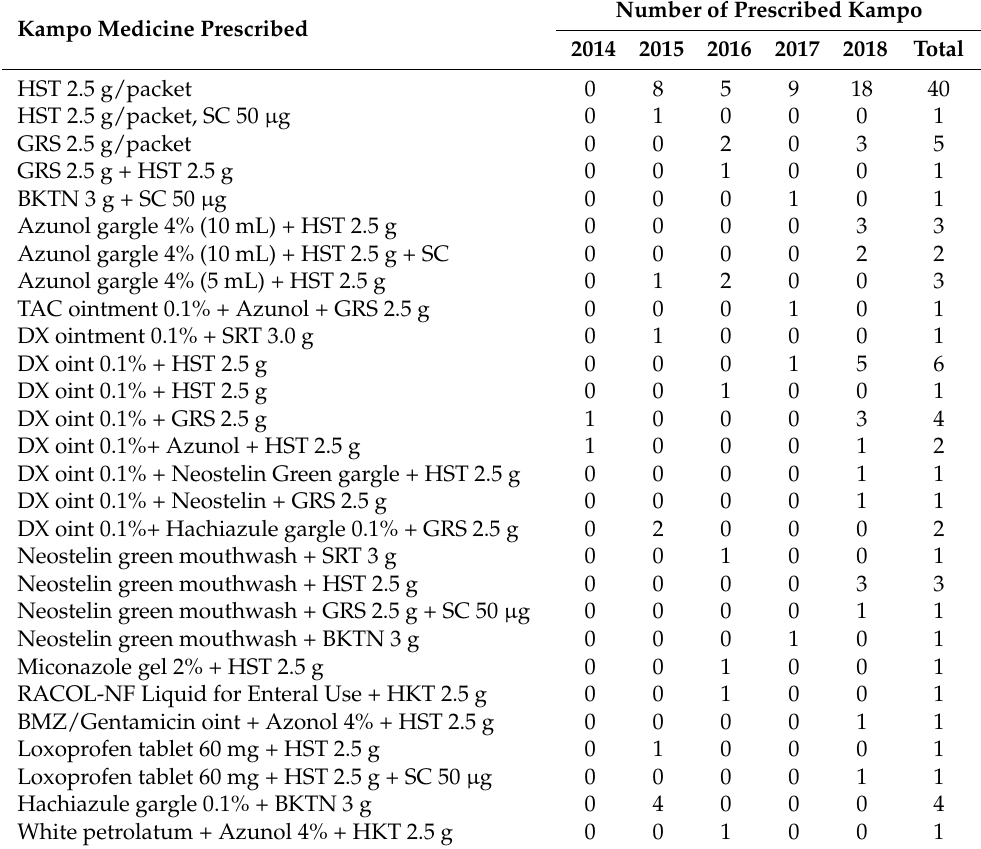
Table 2. Kampo medicines prescribed for stomatitis in the hospital of Nihon University School of Dentistry. All Kampo medicines are extract granules. BKTN, Byakkokaninjinto; BMZ, betamethasone; DX, dexamethasone, GRS, Goreisan; HKT, Hangekobokuto; HST, Hangeshashinto; SRT, Saireito; SC, Salcoat Capsule for oral spray; TAC, triamcinolone